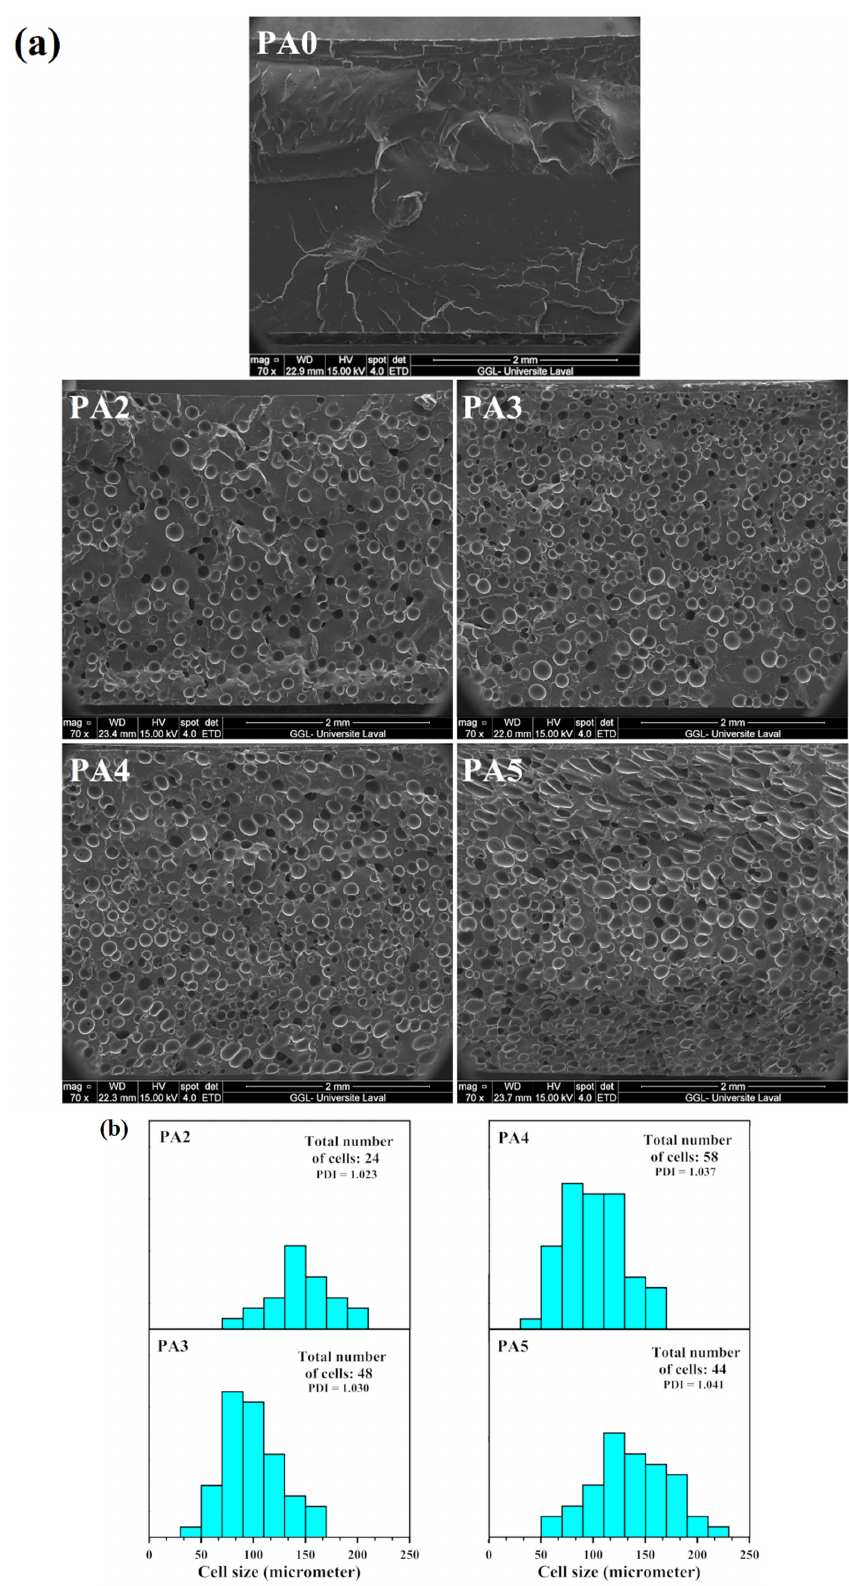
Figure 1. ( a ) SEM images of the POE foams with different ADC contents; ( b ) effect of ADC content on the cell size distribution of POE foams.